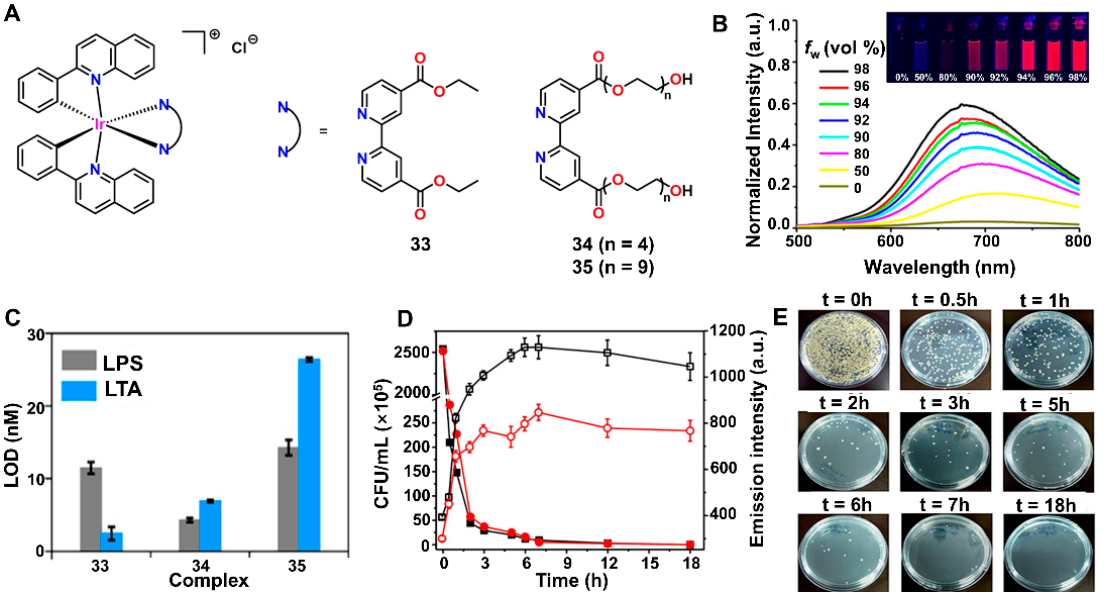
Figure 15. ( A ) The chemical structures of complexes 33–35 . ( B ) Emission spectrum of 34 in H 2 O–THF mixtures with different THF fractions. ( C ) Limit of detection (LOD) of LPS and LTA by the 33–35 confirmed from the linear fit curve of emission titration using fluorescence spectroscopy. ( D ) Kinetics of bacterial detection and growth inhibition. ( E ) Kinetics of growth inhibition for CRAB treated with 34 (15 μ g/mL) in water. Reprinted with permission from [84] , copyright 2020, American Chemical Society.